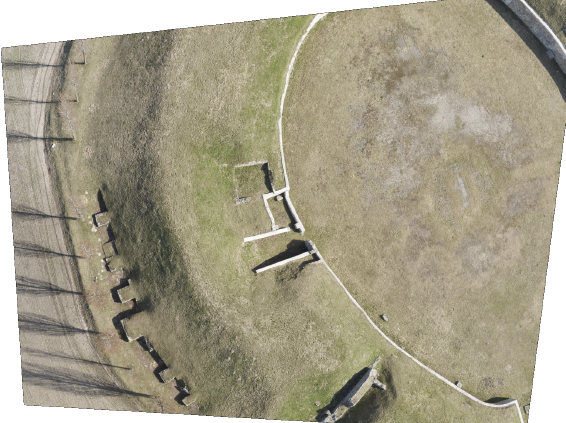
Figure 2: Exemplary UP, rectified w.r.t. an adjusting plane of the sparse point cloud reconstructed along with relative orientations (see fig.